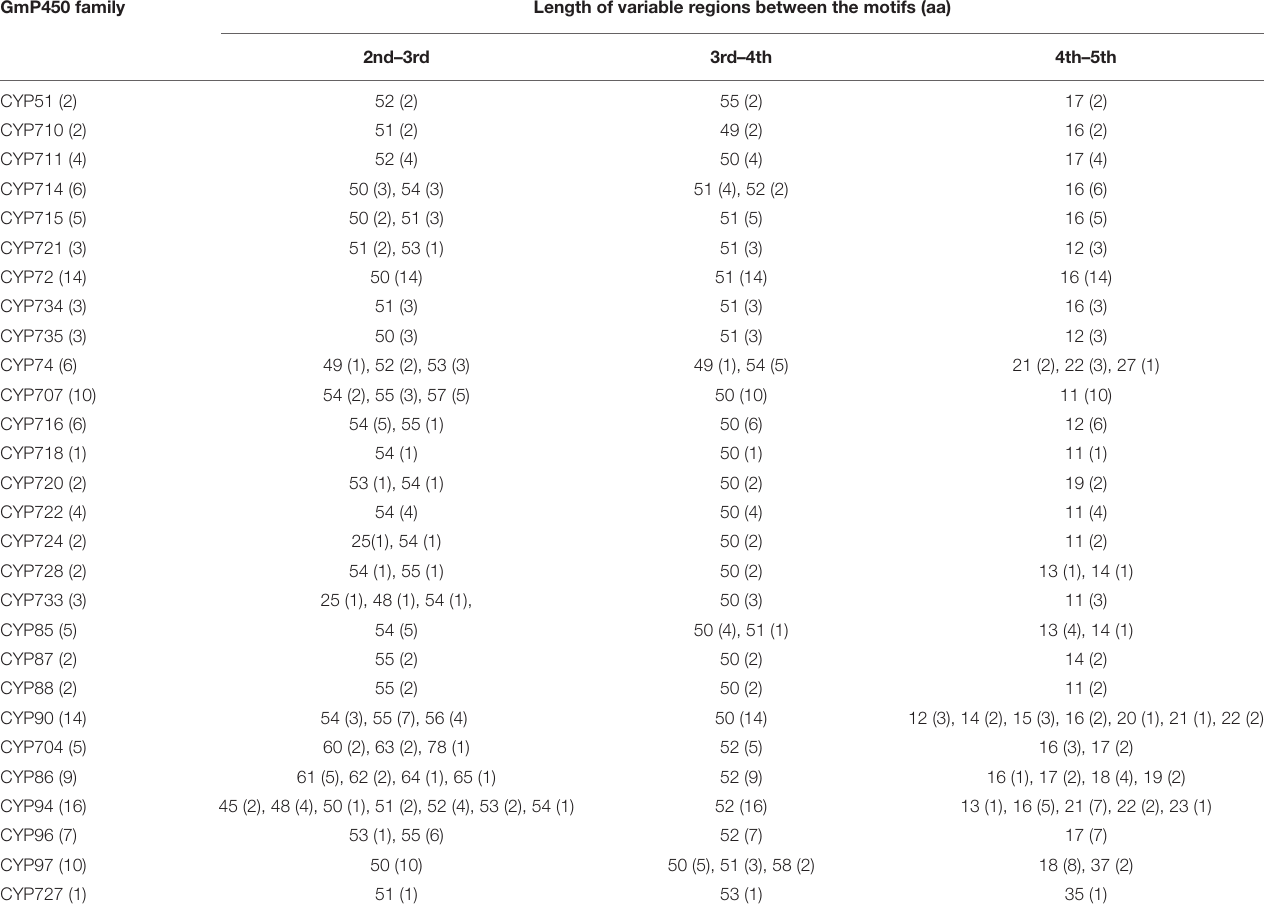
TABLE 4 | Length of variable regions between the conserved motifs in non-A-type GmP450 families.